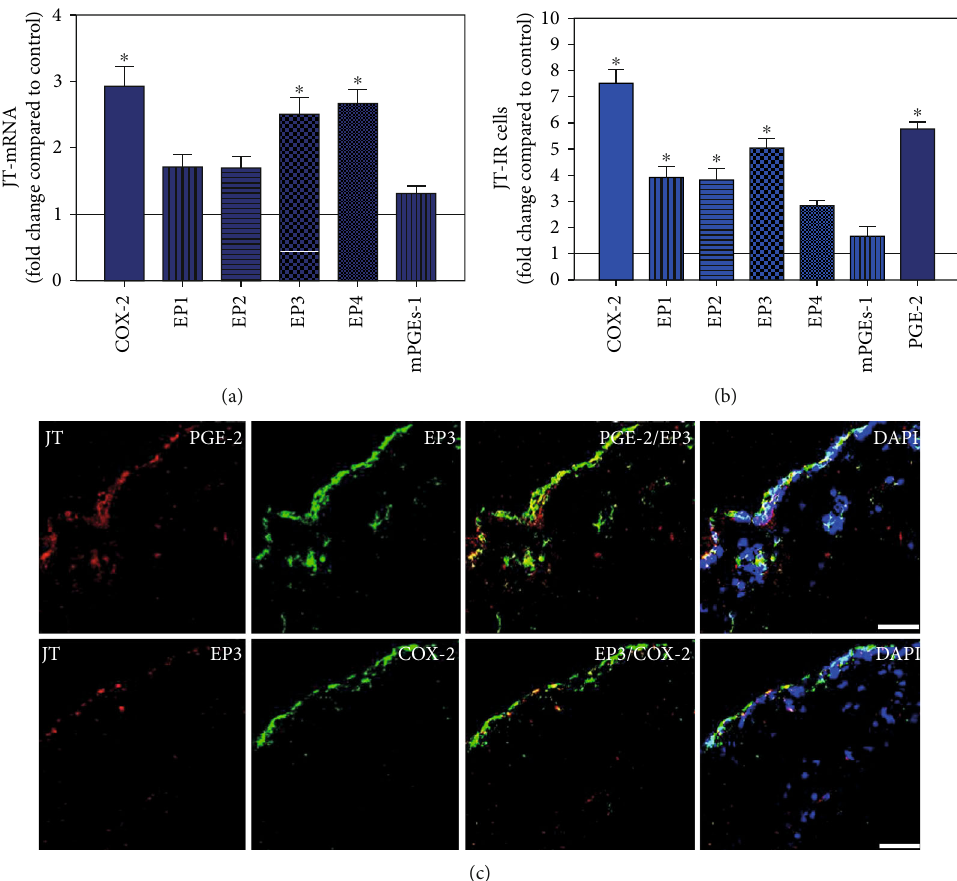
Figure 8: Detection of mRNA (a) and the number of cells immunoreactive for di ff erent components of the prostanoid system (PGE2, mPGES, COX-2, and EP1-4) (b) in patients with joint trauma (JT). (a) Quanti fi cation of mRNA speci fi c for COX2, EP1-4, and mPGEs-1 in synovium of JT patients. (b) Quantitative comparison of COX2-, EP1-4-, and mPGEs-1-IR cells in synovium of JT patients. Data are shown as means ± SEM . (c) Confocal microscopy of EP3 (Texas red fl uorescence; a, b) and mPGES or COX2 (FITC green fl uorescence; c, d) double immuno fl uorescence (e – h) in JT synovium. DAPI blue fl uorescence shows nuclear staining. Bar = 40 μ m